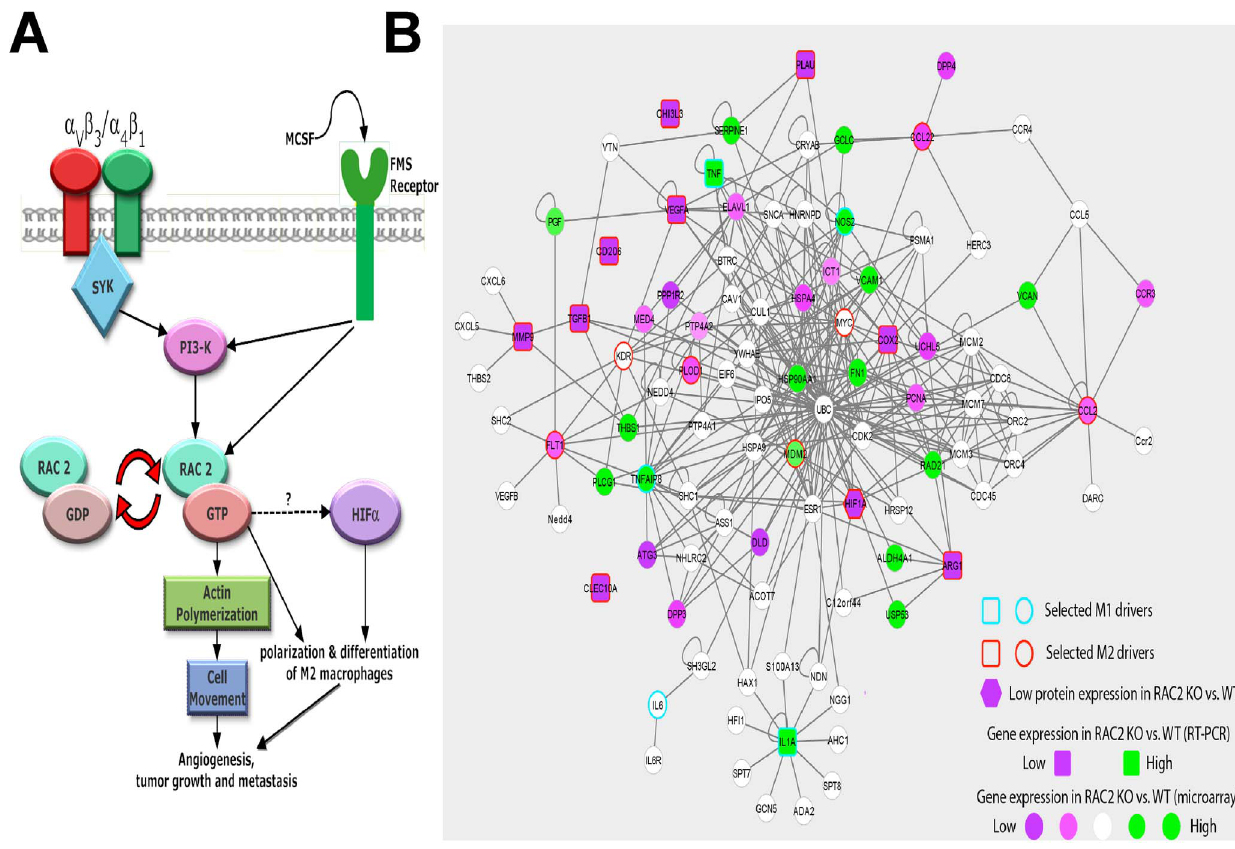
Figure 7. Identification of Rac2 regulated signaling pathways controlling differentiation of macrophages into M2 phenotype. (A) Graphic representation of novel integrin-Rac2 signaling axis in macrophages required for tumor growth, invasion, metastasis and the polarization of macrophages into M2 phenotype. (B) Interactome map developed from multiple-omic data which predicts how Rac2 regulates macrophage M2 differentiation. Nodes indicate genes either preselected for hierarchical analysis (colored borderer) or prioritized directly by the network propagation algorithm. Edges indicate protein-protein interactions. Node color indicates the protein or gene expression change in the Rac2-/- vs. WT condition.